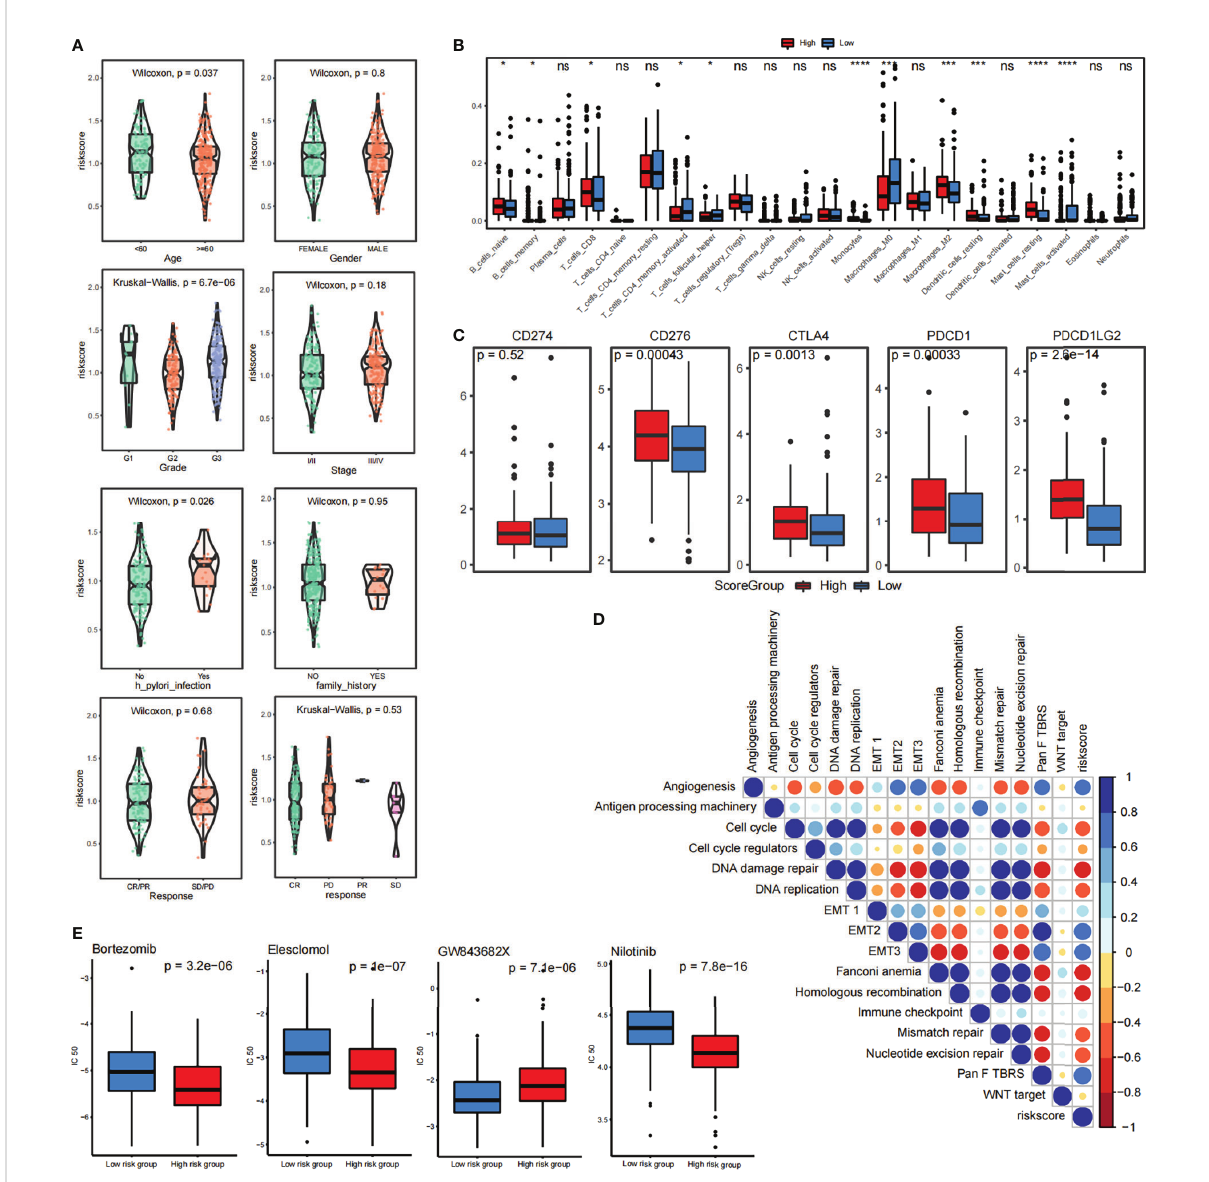
FIGURE 4 Relationship between risk scoring system and immune in fi ltration and immunotherapy (A) Analysis of correlation between risk score and clinical characteristics of patients with STAD (B) CIBERSORT calculated the relationship between immune cell in fi ltration and risk score (C) The difference of gene expression in immune checkpoint between high and low score groups. (D) Pearson analysis of SSGSEA score and fatty acid risk score. (E) Correlation analysis between fatty acid risk score and chemotherapy resistance. *p<=0.05, ***p<=0.001, ****p<=0.0001, ns means p >